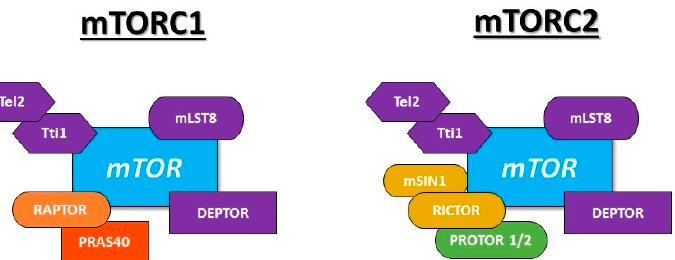
Figure 1. Structure of mTOR complexes. Both shared mTOR that is the catalytic subunit, DEPTOR, which acts as a negative regulator, Tti1/Tel2, as scaffold proteins, and mLST8, which function is unknown. Specifically, mTORC1 is also formed with RAPTOR (scaffold protein) and PRAS40 (inhibitor of RAPTOR); mTORC2 with RICTOR and mSIN1 both acting as a scaffold; PROTOR 1/2 is a positive regulator.